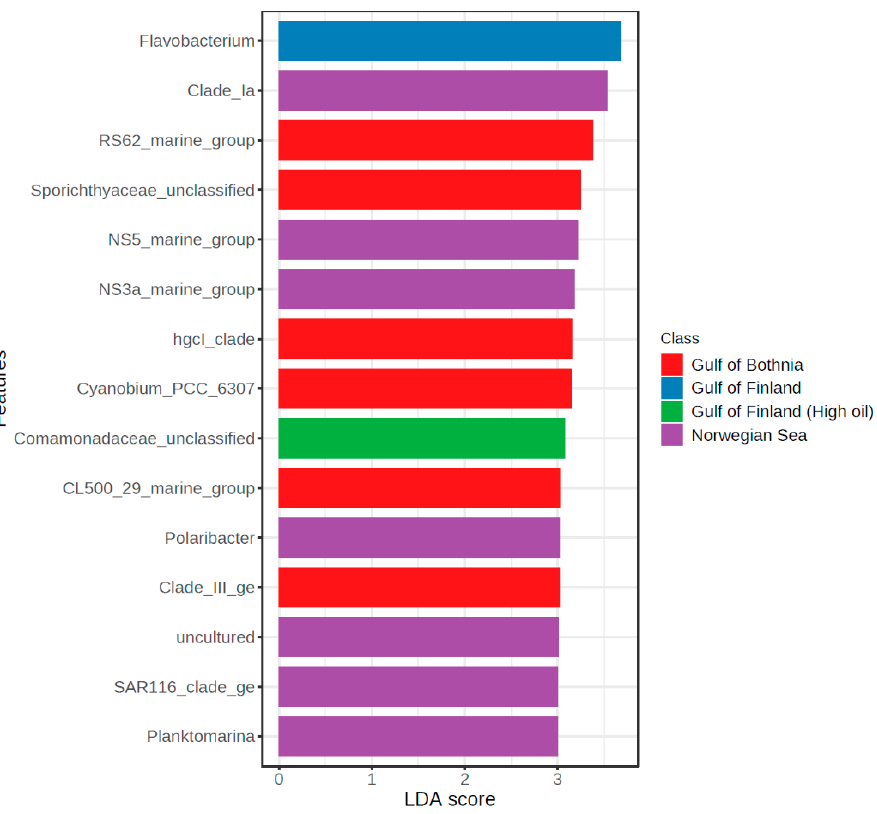
Figure 9. Linear discriminant analysis effect size (LEfSe) analysis of microbial communities compar- ing seawater from different experiments.